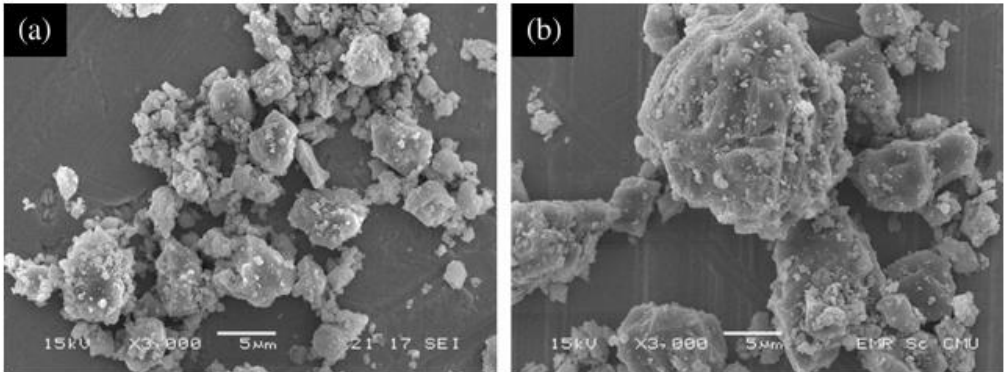
Figure 6. Scanning electron microscopy (SEM) images of limestone powder with particle size of ( a ) 5 μm and ( b ) 20 μm [35].